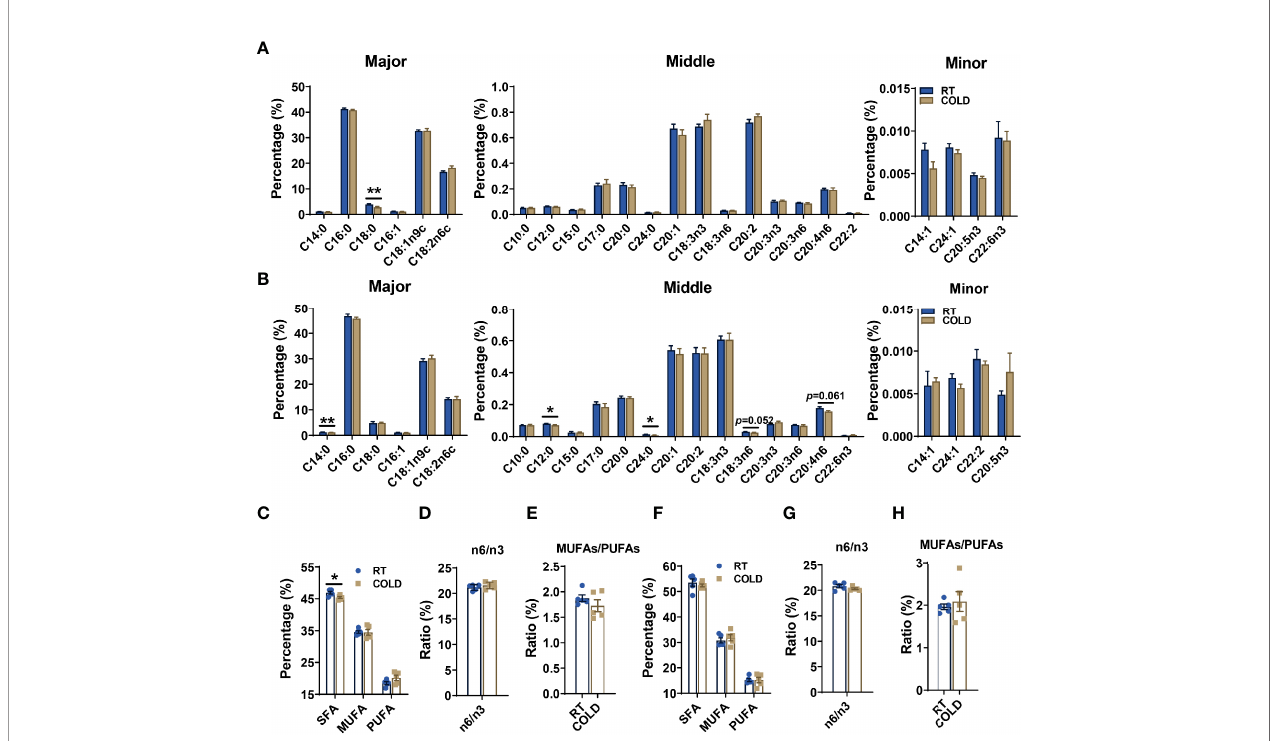
FIGURE 2 | Cold exposure changed the composition and proportions of fatty acids. Fatty acid composition analyses of SAT and VAT isolated from pigs maintained at RT or in COLD for 14 hours. (A) The relative concentration of individual fatty acids in SAT from RT and COLD pigs. Fatty acids are divided into major, middle and minor species based on abundance. Fatty acids are sorted by a degree of saturation. (B) The relative concentration of individual fatty acids in VAT from RT and COLD pigs. (C) The percentages of total SFAs, MUFAs and PUFAs in SAT from RT and COLD pigs. SFAs, saturated fatty acids; MUFAs, monounsaturated fatty acids; PUFAs, polyunsaturated fatty acids containing two or three to six double bonds. (D) The ratio of n6-fatty acids: n3-fatty acids (n6: n3) and (E) MUFAs: PUFAs in SAT from RT and COLD pigs. (F) The percentages of total SFAs, MUFAs and PUFAs in VAT from RT and COLD pigs. (G) The ratio of n6-fatty acids: n3-fatty acids (n6: n3) and (H) MUFAs: PUFAs in VAT from RT and COLD pigs. n = 5. Error bars represent S.E.M. * P < 0.05, ** P < 0.01, two-tailed Student ’ s